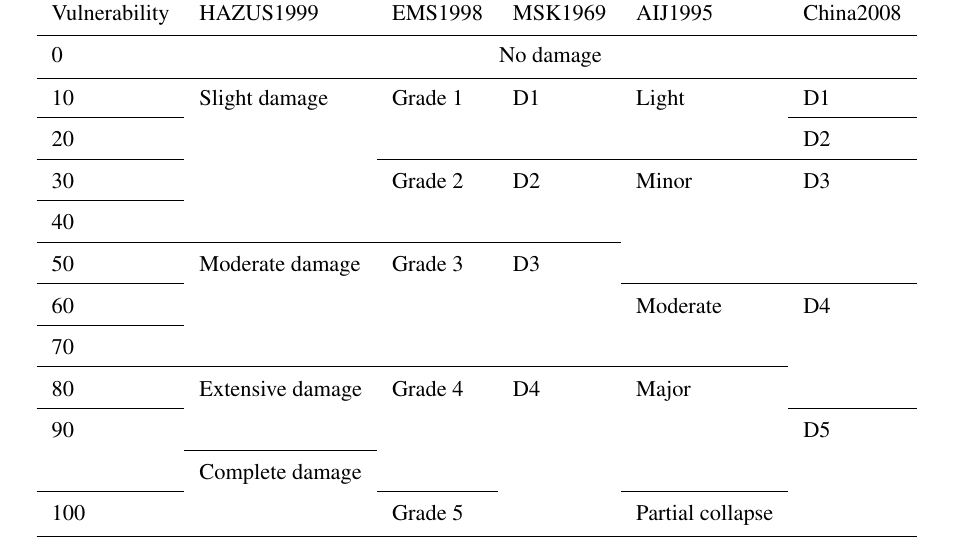
Table 1. Example of major damage state classification methods (modified after Rossetto and Elnashai, 2003).